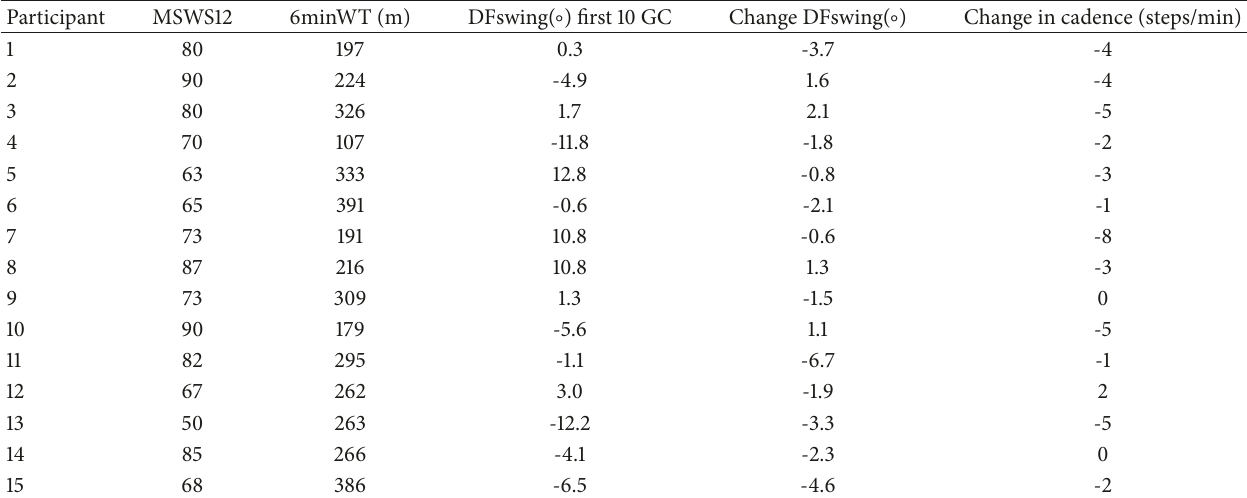
Table 3: Individual results for all